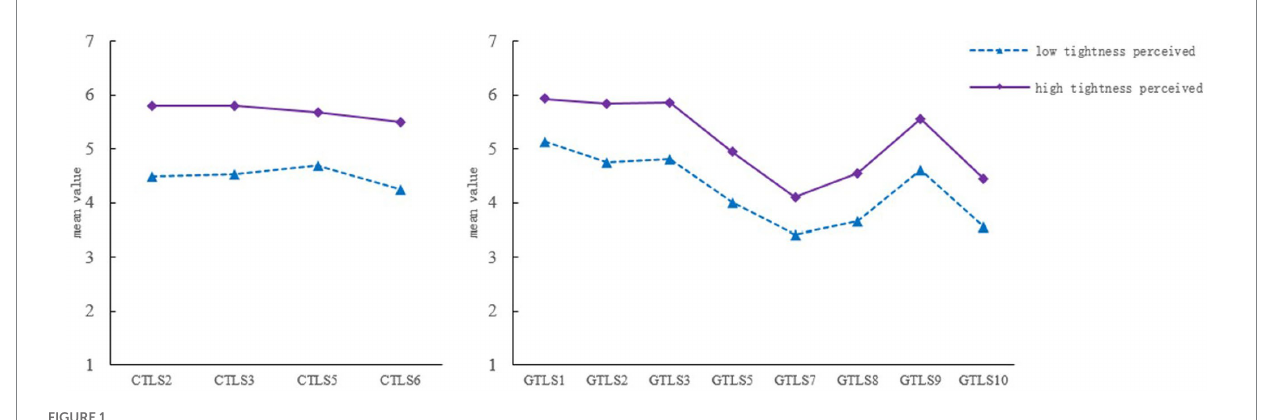
FIGURE 1 LPA of perceived national cultural tightness and general life